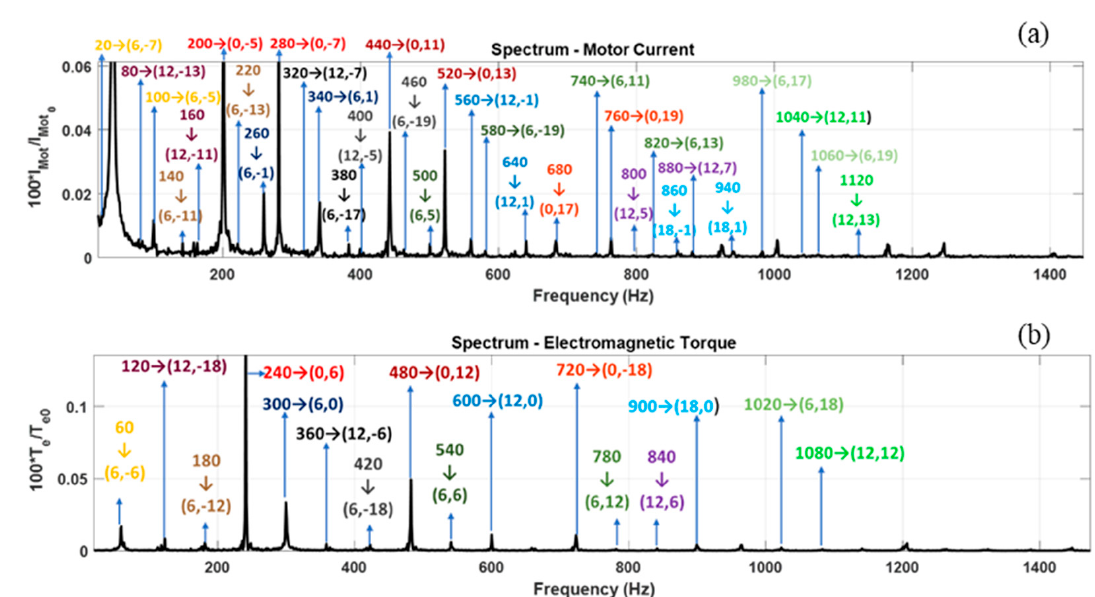
Figure 17. Detailed analysis of motor current and air-gap torque harmonic families of a 6/6-pulse LCI system at 40 Hz: ( a ) motor current spectrum and ( b ) air-gap torque spectrum.